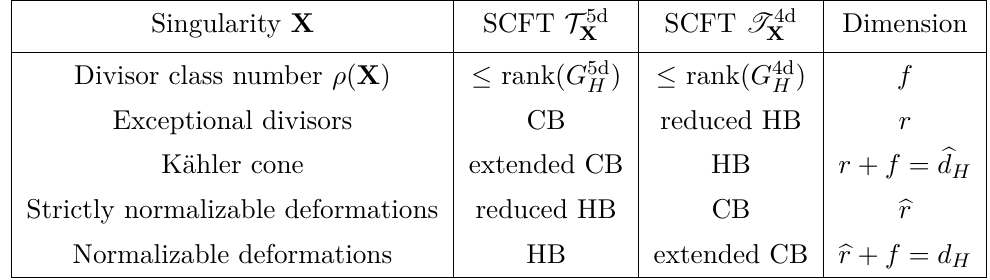
Table 1 . 5d and 4d SCFTs from a canonical singularity X , at a glance. See section 2 for